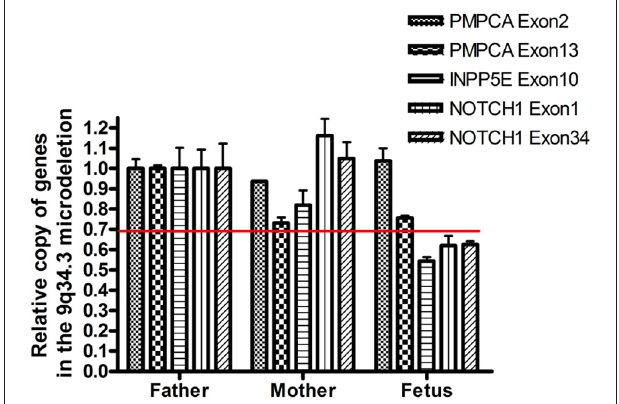
FIGURE 3 | Confirmation of the presence of the deletion by semi-quantitative q-PCR. The copy number of PCPMA , INPP5E , NOTCH1, and 36B4 was evaluated by semi-quantitative PCR. The relative copies of PCPMA (exon 2 and 13), INPP5E (exon 10) and NOTCH1 (exon 1 and 34) were normalized using, a valid single copy